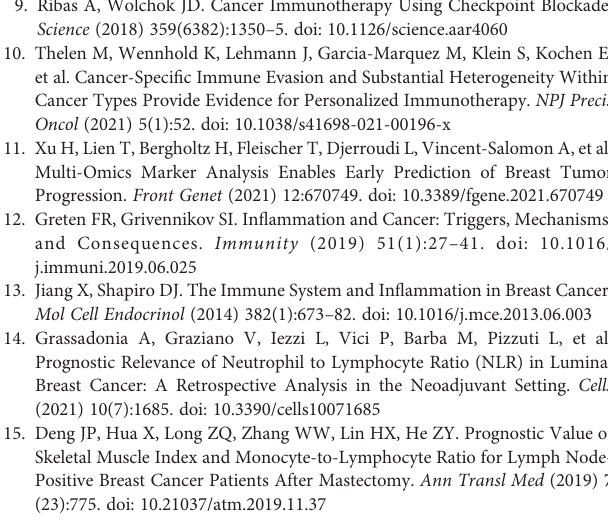
Supplementary Figure 1 | Receiver operating characteristic curve (ROC) for LDH and dNLR. Supplementary Figure 2 | Forest plots for multivariate Cox proportional hazards regression model. A) Multivariate analysis for Disease free survival; 2) Multivariate analysis for Overall survival. Supplementary Figure 3 | Kaplan-Meier curves for disease-free survival (DFS) andoverallsurvival(OS). (A) Kaplan-MeiercurvesforDFSforLDH; (B) Kaplan-Meier curves for OS for breast immune LDH; (C) Kaplan-Meier curves for DFS for dNLR; (D) Kaplan-Meier curves for OS for breast immune dNLR. Supplementary Figure 4 | Dynamic Nomogram for predicting the survival. (A) Dynamic Nomogram for DFS; (B) Dynamic Nomogram for OS. Supplementary Figure 5 | Decision curve analysis (DCA) of the BIPI and pathological Nstageor pathologicalTNM stage for predicting thediseasefreesurvival (DFS) and overall survival (OS). The X axis represents threshold probability, and the Y axis shows net bene fi t. The lines between the X-axis and the Y-axis displays the bene fi t of different predictive variables. The red dotted line suggested that no patient has poor prognosis, while the red line indicated that all patients have poor prognosis. The blue line represented BIPI, and the green line represented only pathological N stage or pathological TNM stage. (A) DCA of the BIPI and pathological N stage for predicting the 5-year DFS; (B) DCA of the BIPI and pathological N stage for predicting the 5-year OS; (C) DCA of the BIPI and pathological TNM stage for predicting the 5-year DFS; (D) DCA of the BIPI and pathological TNM stage for predicting the 5-year